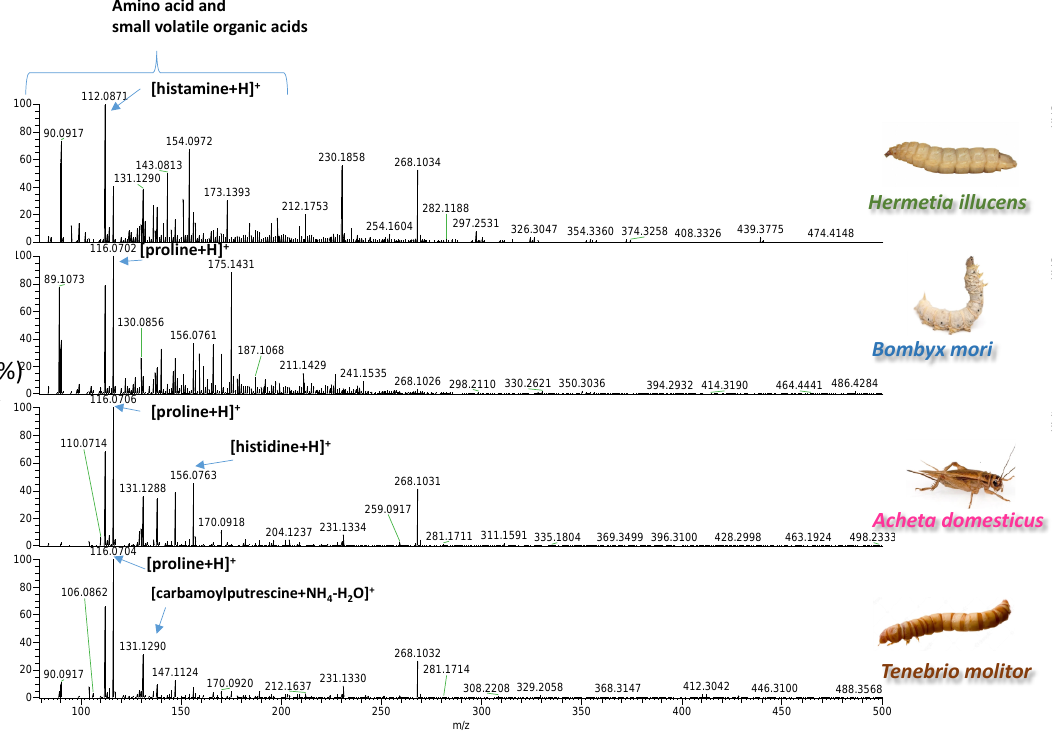
Figure 3. DART-HRMS spectra of the extracts A of edible powders of Hermetia illucens , Bombyx mori , Acheta domesticus , and Tenebrio molitor acquired in negative ion mode. The acquired spectra are zoomed in, to facilitate the visualization of the most informative m/z range between 75 – 500 Da.